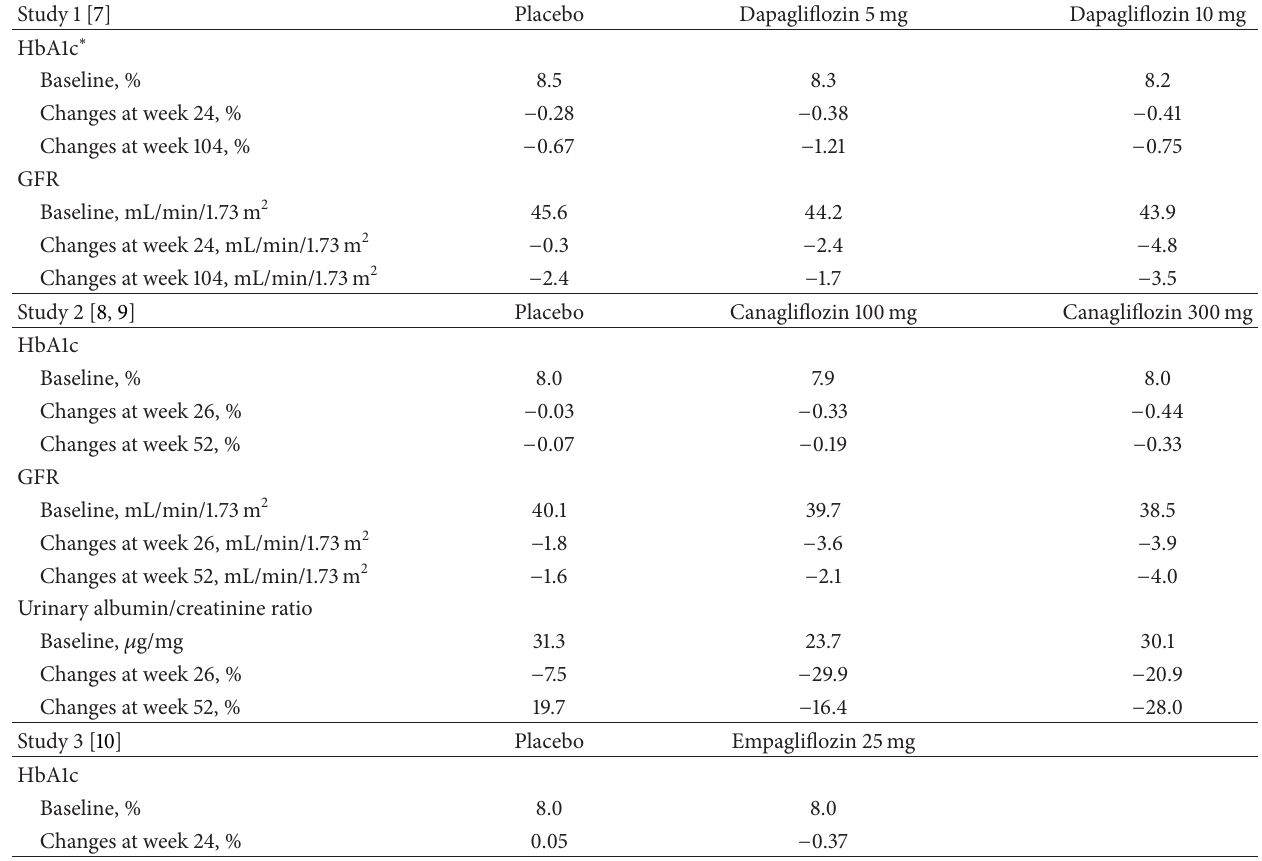
Table 1: Glycaemic control and renoprotection in studies of SGLT2 inhibition in subjects with moderate chronic kidney